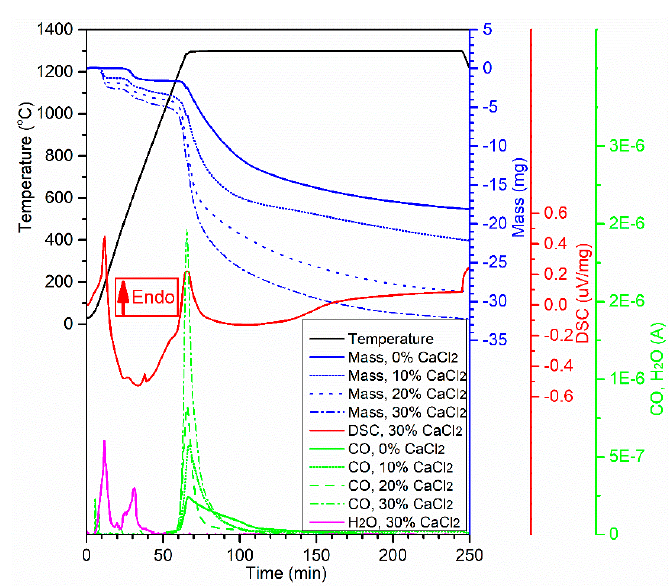
Figure 2. Isothermal thermogravimetric analysis (TG-DSC-MS) tests at 1300 °C, varying the amounts of CaCl 2 addition.